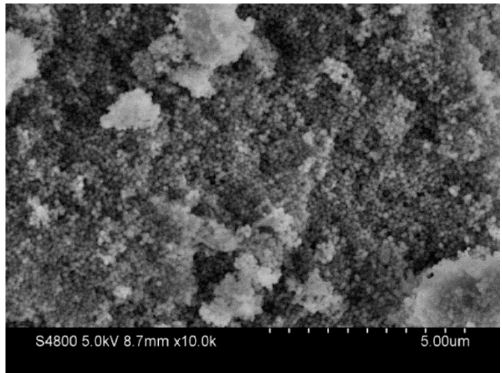
Figure 4. The SEM image of the SN-modified underwater composite-repairing